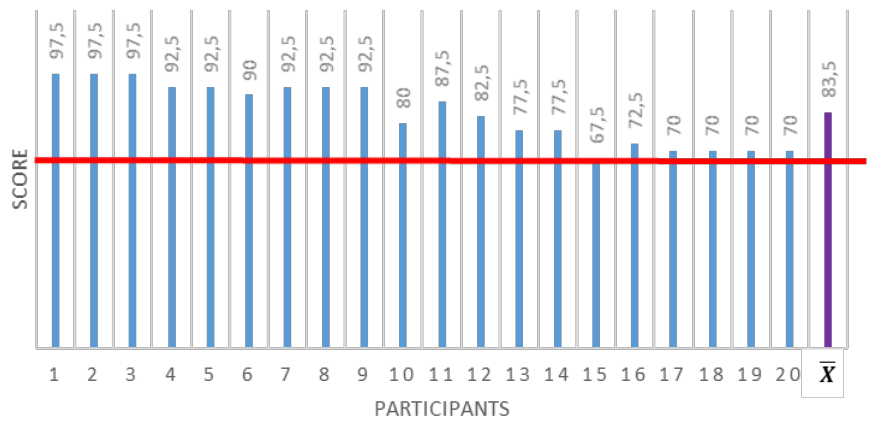
Figure 11. Score per participant obtained by SUS test.